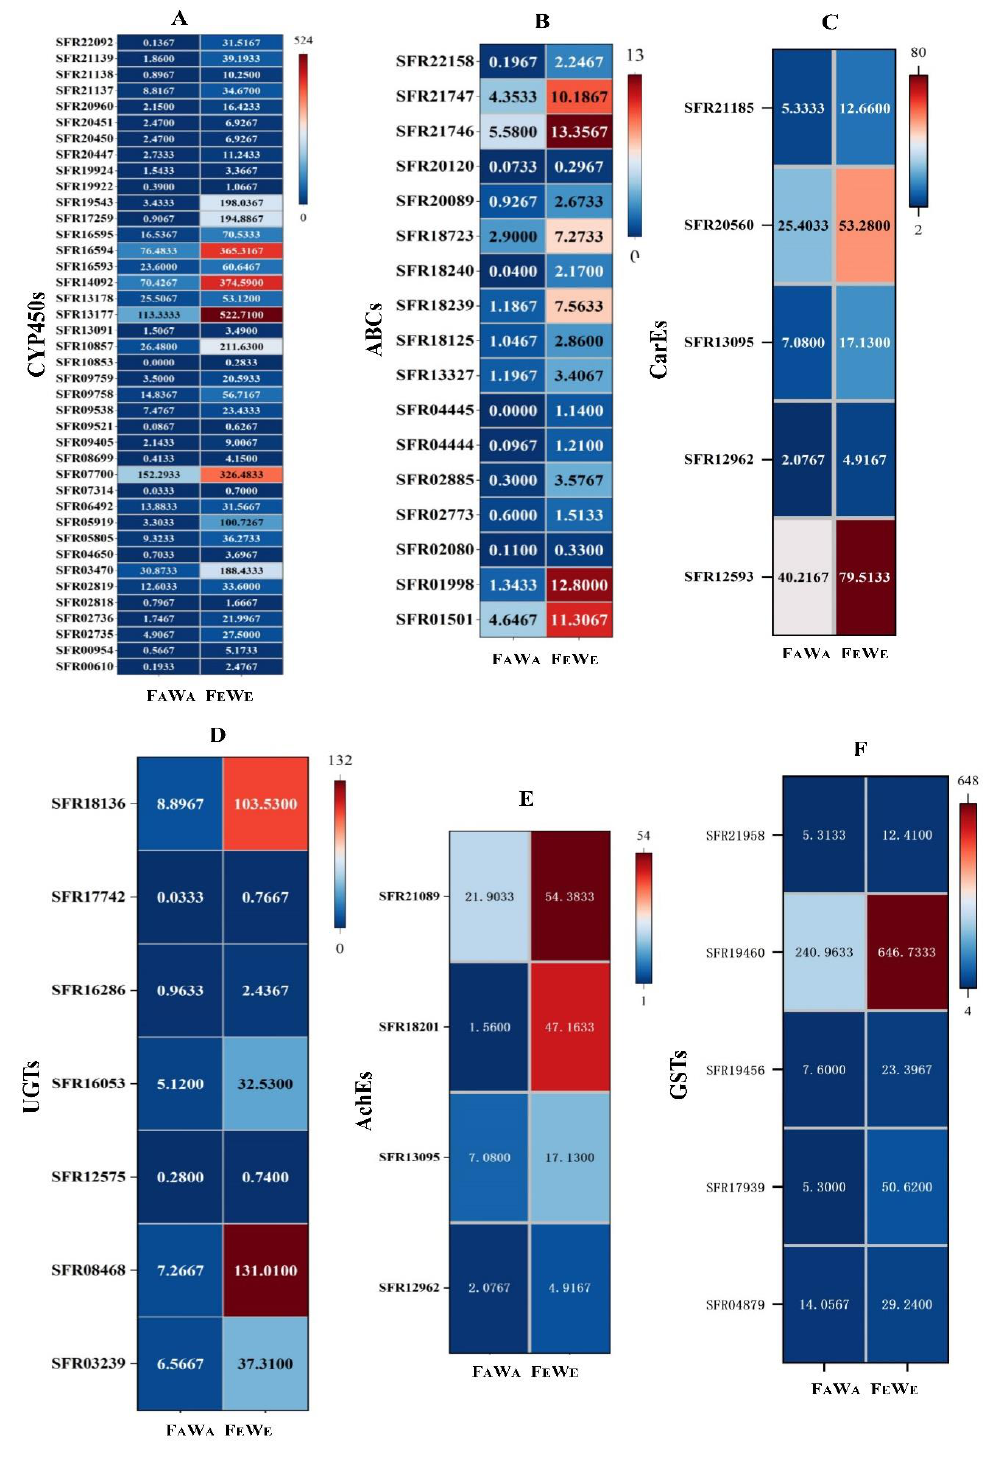
Figure 5. Heatmap of differentially expressed genes of F A W A versus F E W E . ( A ): Heatmap of cytochrome P450 monooxygenase (P450) DEGs. ( B ): Heatmap of ATP-binding cassette transporter (ABC) DEGs. ( C ): Heatmap of carboxylesterase (CarE) DEGs. ( D ): Heatmap of UDP glucosyltransferase (UGT) DEGs. ( E ): Heatmap of acetylcholinesterase (AchE) DEGs. ( F ): Heatmap of glutathione S-transferase (GST) DEGs. Note: Heatmaps show the average values of FPKM. The x-axis shows the different treatments (F A W A and F E W E ). The colour represents the fold change of DEGs; red indicates upregulation, and blue indicates